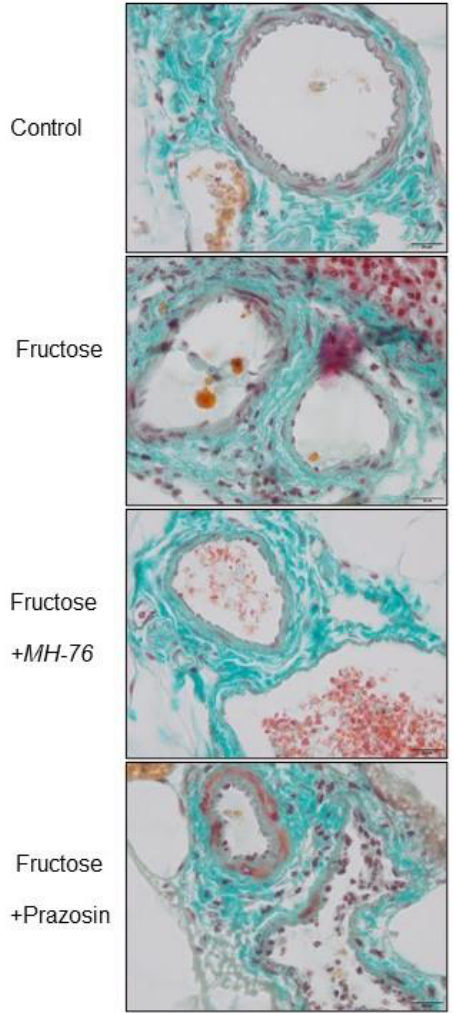
Figure 7. Representative histological pictures of blood microcirculation in adipose tissue sections stained with Masson’s trichrome (bar = 20 µm). The symptoms of the inflammatory phenotype (in regards to endothelial damage, leukocyte adhesion and extravasation, perivascular lymphocyte and macrophage aggregation) shown for the Fructose and Fructose + Prazosin rats. Microvasculature of Fructose + MH-76 treated rats tended to display weakened, and overall mild, inflammatory symptoms comparing to the Fructose rats. For Fructose + MH-76 arterioles, frequency of signs of endothelial damage, leukocyte peripheralization and extravasation and perivascular leucocytes aggregation was statistically significantly lower than in the Fructose group ( p < 0.05; Figure 8D). Comparing the Fructose + MH-76 versus Fructose + Prazosin groups, we noticed statistically significantly enhanced vascular inflammatory symptoms in the Fructose + Prazosin treated animals, especially in venules and small veins ( p < 0.05; Figure 8B,C) and in arterioles ( p < 0.01; Figure 8D).